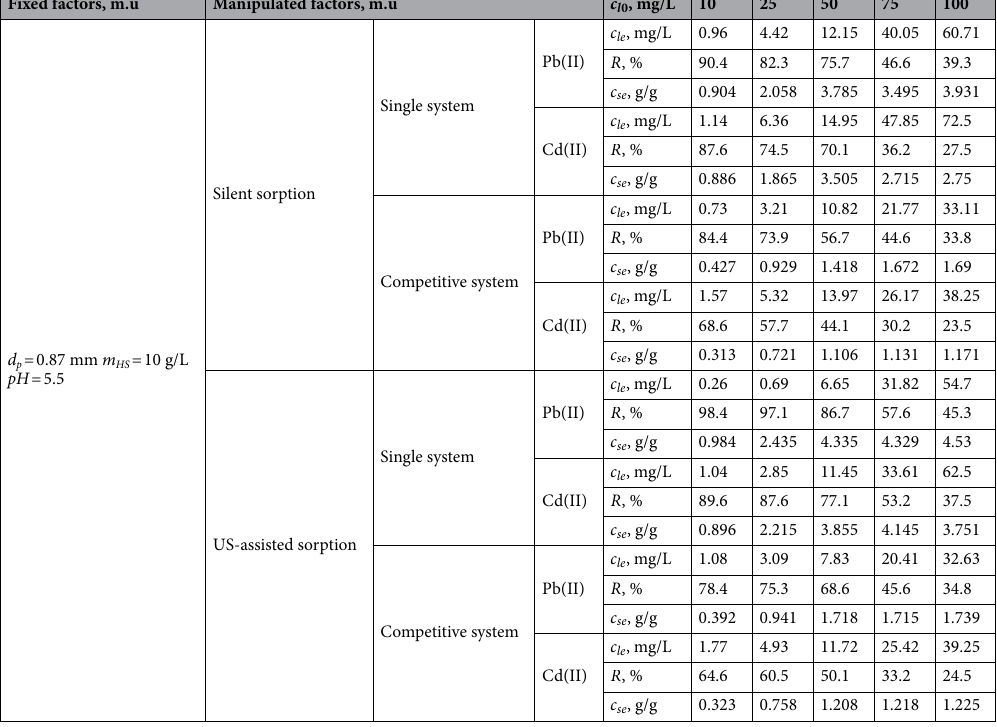
Table 3. Experimental parameters and equilibrium data for Pb(II) and Cd(II) sorption on HS at 25 °C.